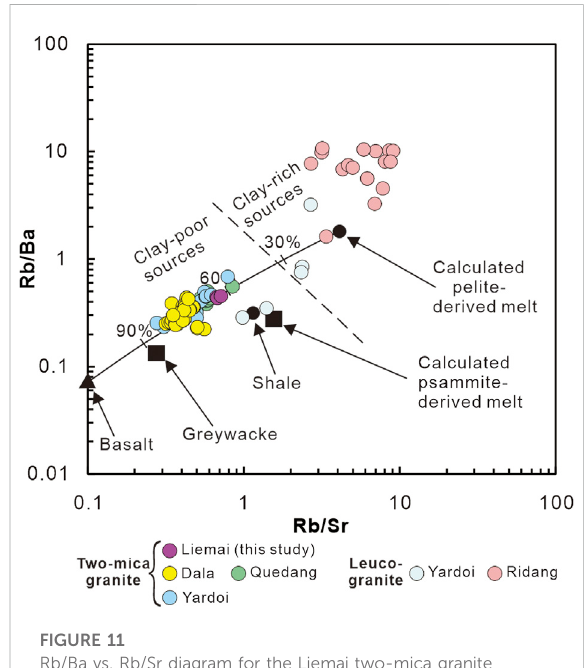
FIGURE 11 Rb/Ba vs. Rb/Sr diagram for the Liemai two-mica granite (Sylvester, 1998). Data source: the granites and leucogranites are the same as in Figure